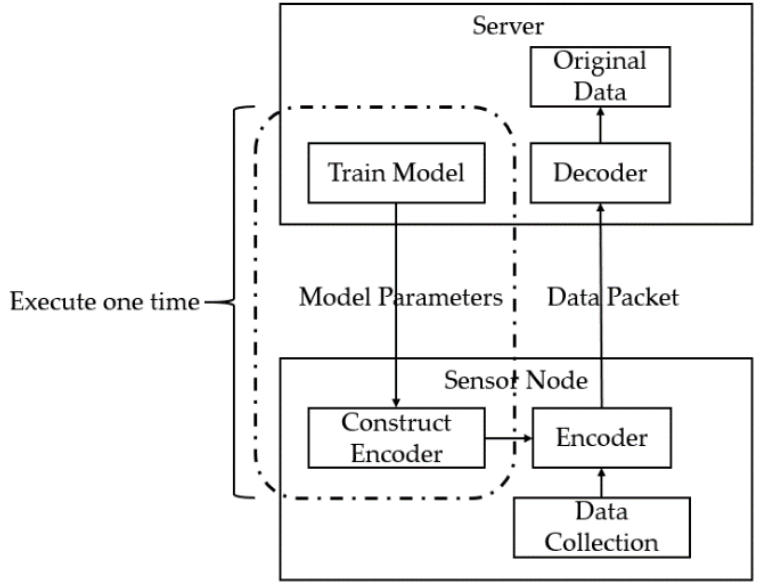
Figure 12. The process of the model solution.